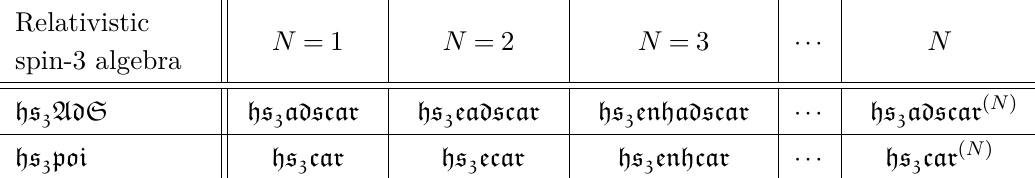
Table 2 . Ultra-relativistic expansions of spin-3 AdS and spin-3 Poincaré